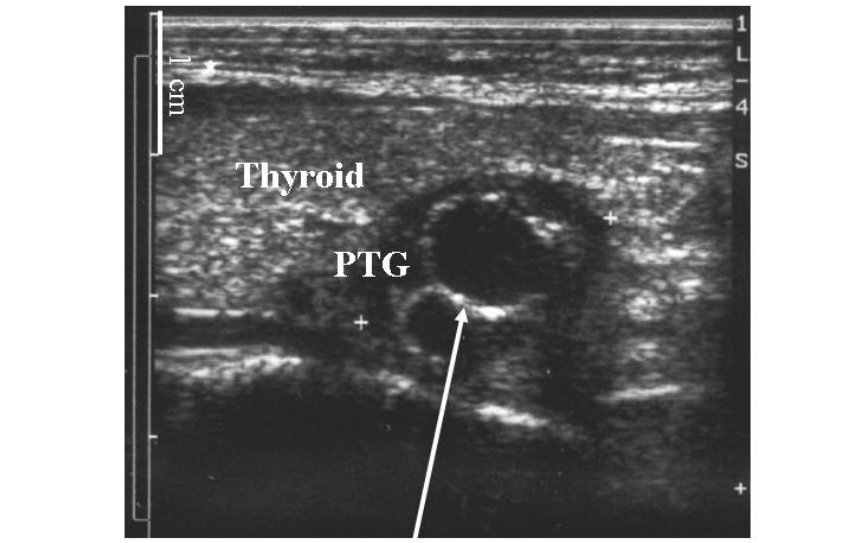
FIGURE 9. PTG with cystic degeneration in 50-year-old woman, on dialysis treatment 7 years, PTH 626.6 pg/ml (longitudinal section, linear probe 10 MHz).